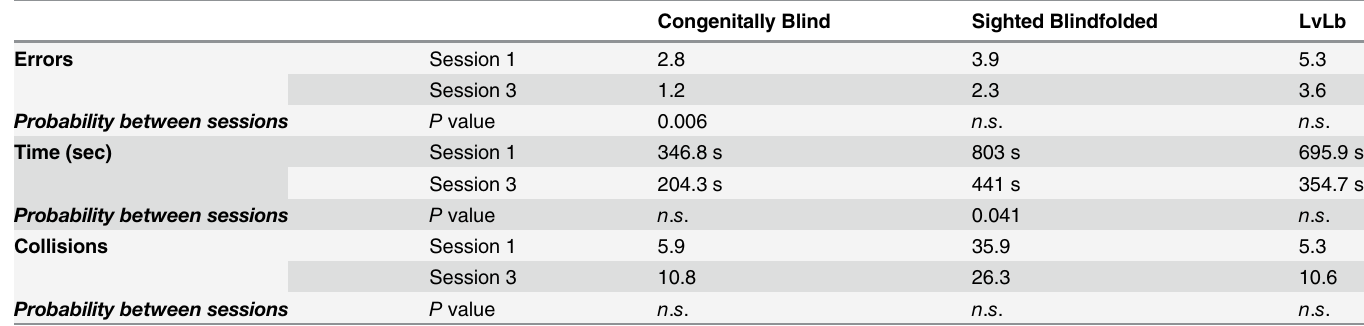
Table 3. Results Virtual